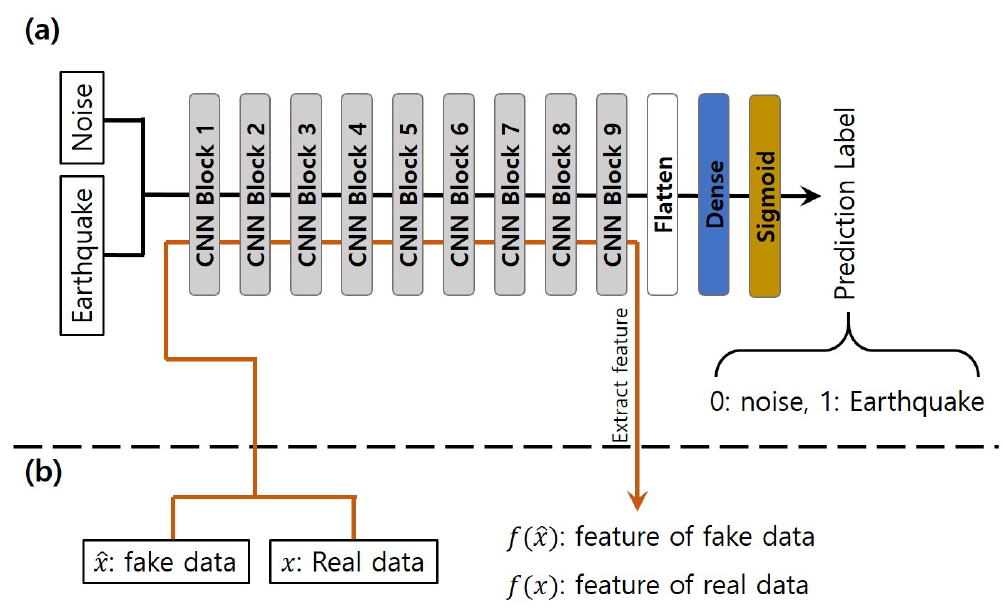
Figure 5. ( a ) Architecture of pre-trained classifier, ( b ) the schematic diagram of pre-trained classifier employed in GAN